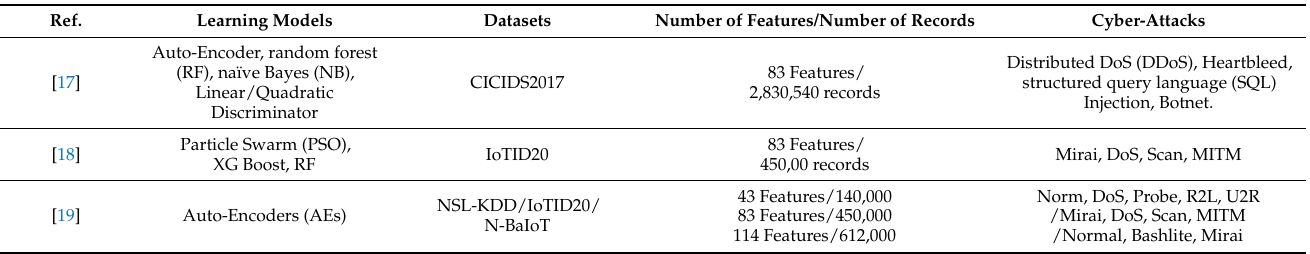
Table 1. Summary of surveyed related research articles of supervised ML-based anomaly IDS.